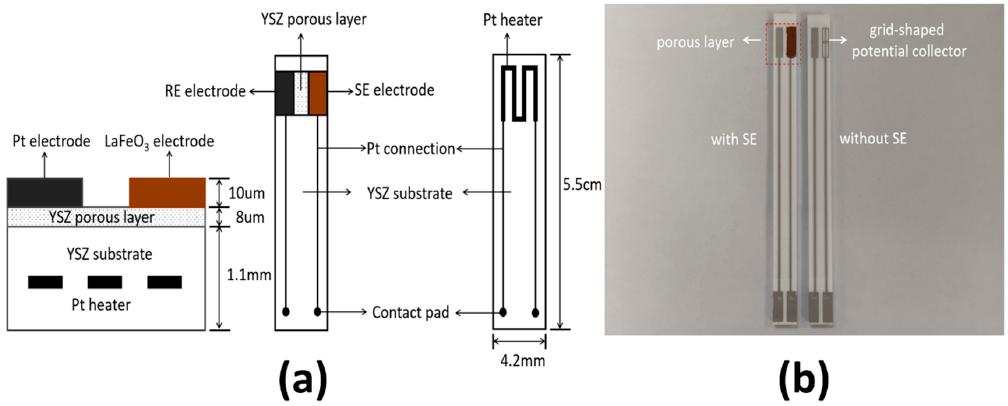
Figure 1. ( a ) Schematic structure and ( b ) the top view of the sensor.